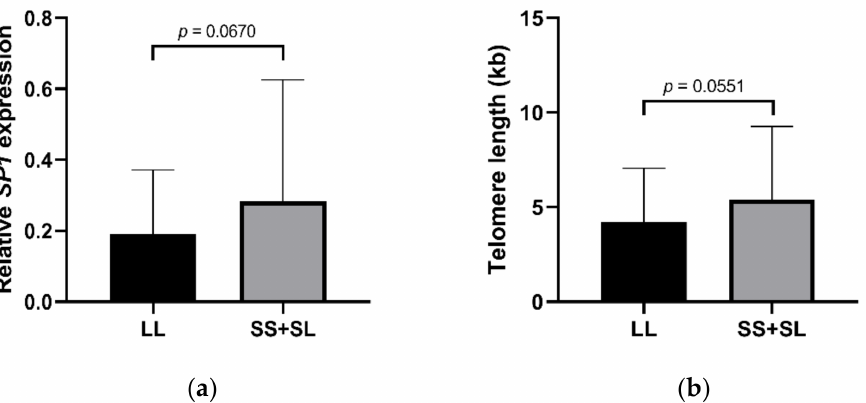
Figure 5. Relationship between the TERT VNTR-MNS16A polymorphism, relative SP1 expression and telomere length. High relative expression of the SP1 gene is associated with short allele (S) TERT VNTR-MNS16A ( a ), which was associated with long telomeres ( b ). The Mann-Whitney U test was employed to assess the significance of differences in the expression level of SP1 ( a ) and the differences of telomere length ( b